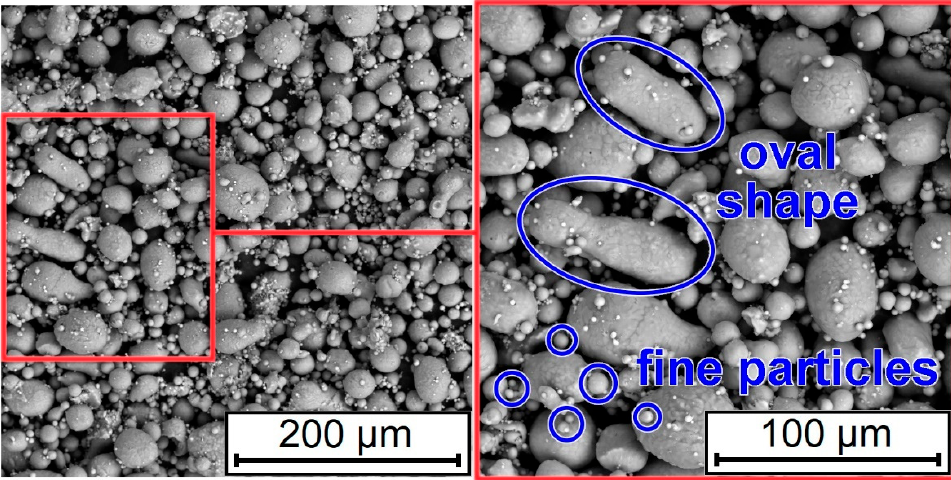
Figure 4. SEM images of ASP-30 powder before classification .